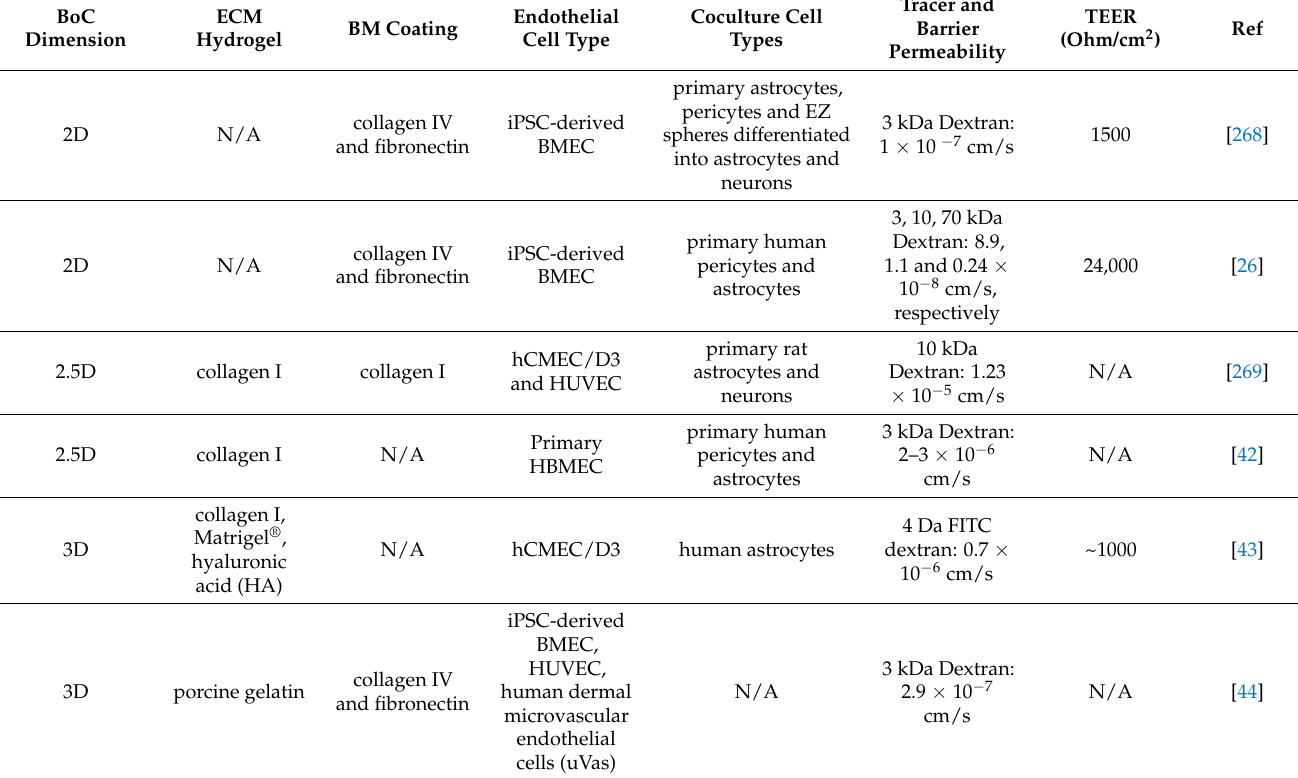
Table 1. Hydrogels and coatings previously used in 2D, 2.5D and 3D BoC